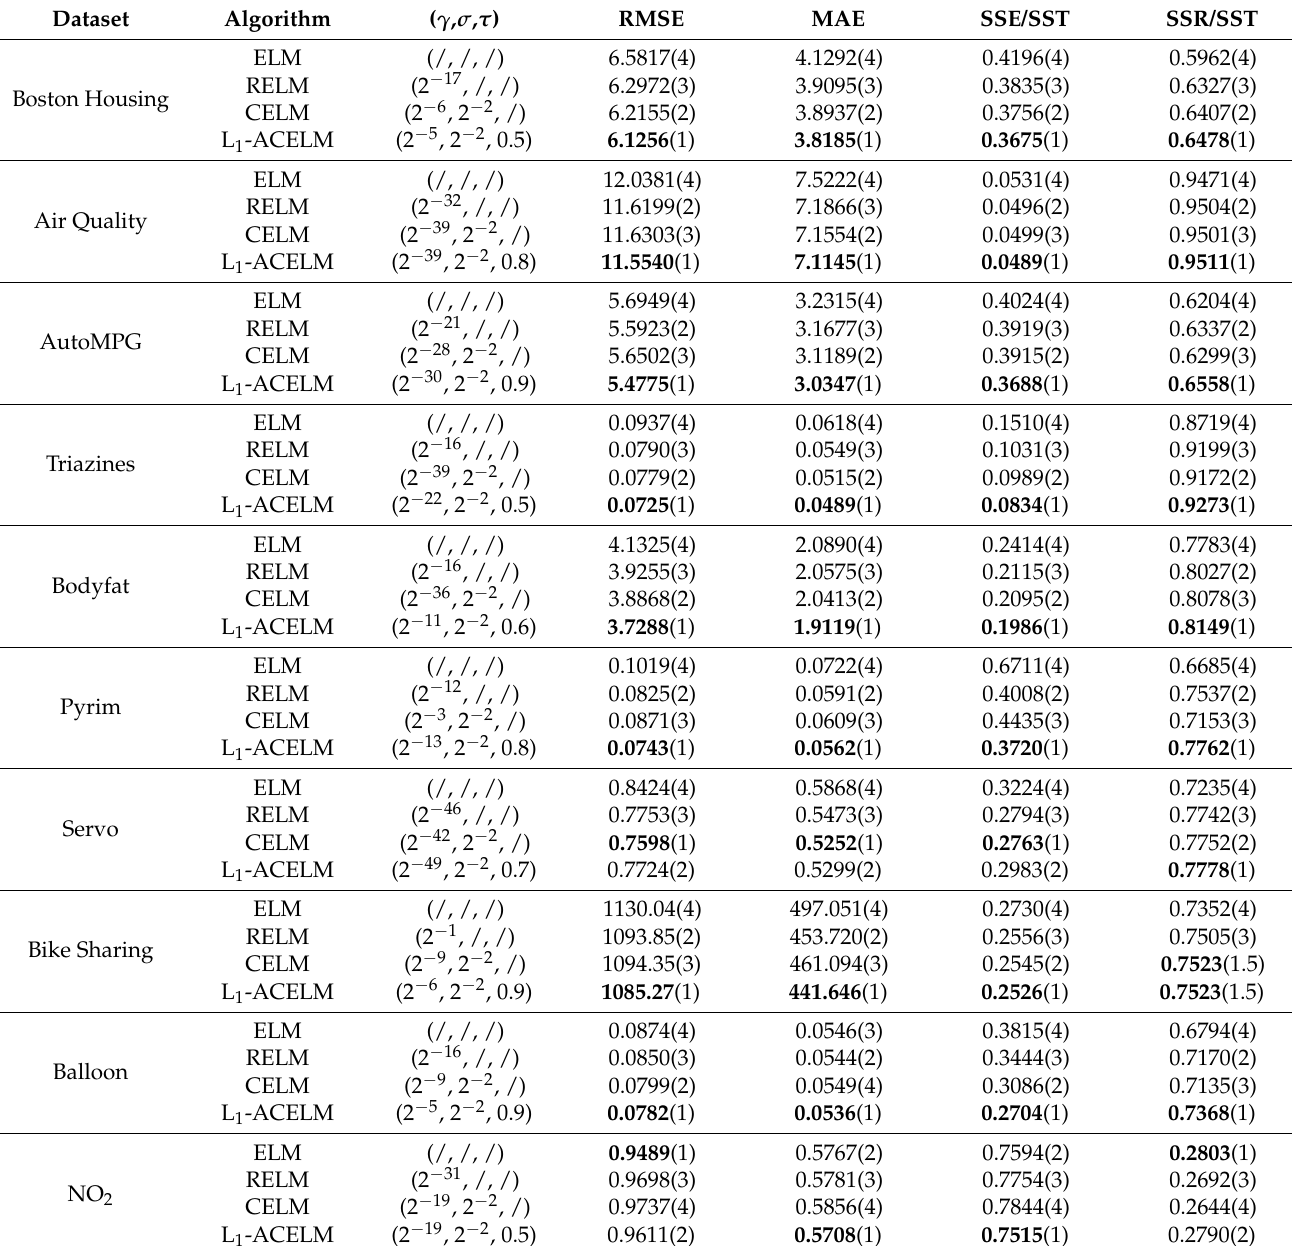
Table 5. Performance of different algorithms under 5% noise